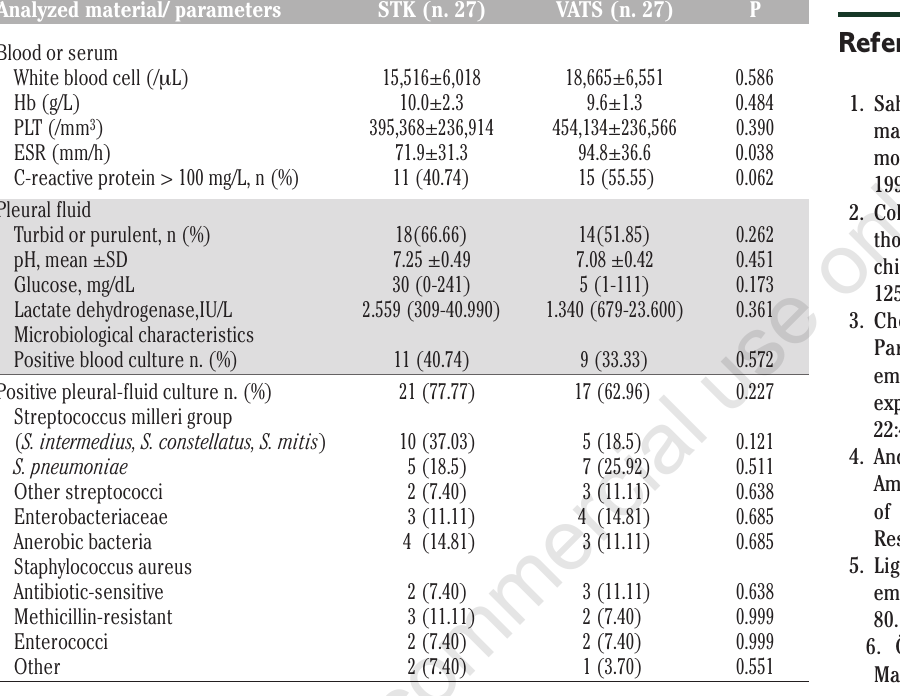
Table 3. Patients’ blood or serum, pleural fluid, and microbiological characteristics. Analyzed material/ parameters